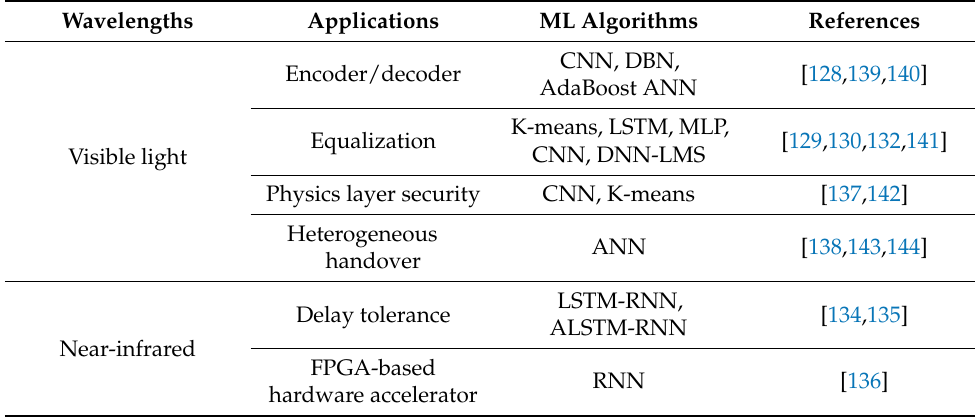
Table 3. A summary of current ML based applications in indoor OWC